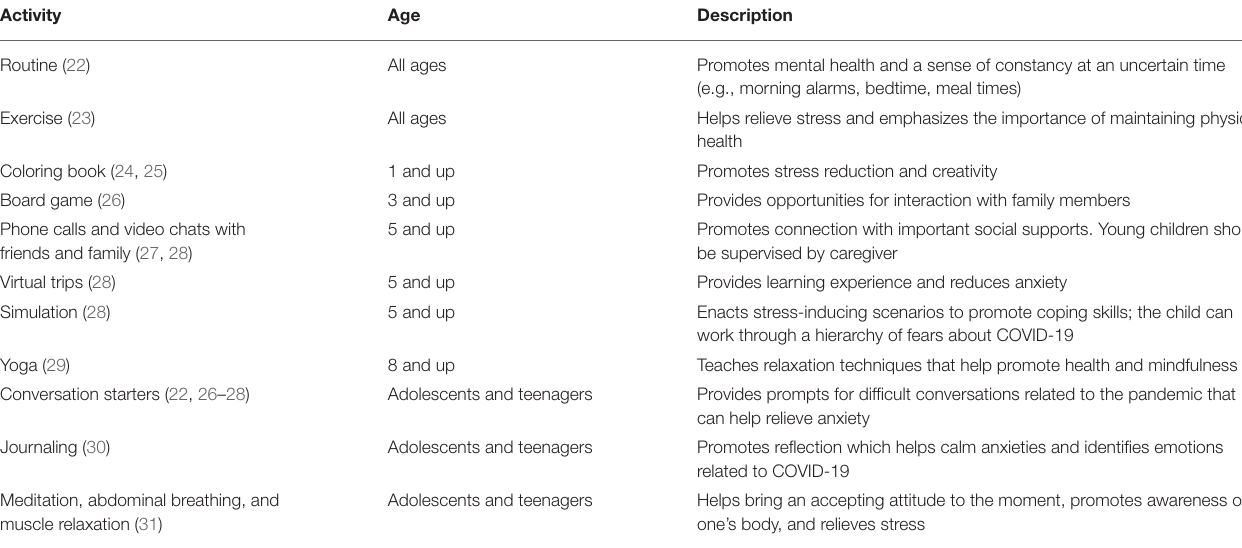
TABLE 1 | Activities and resources for COVID-19 stress